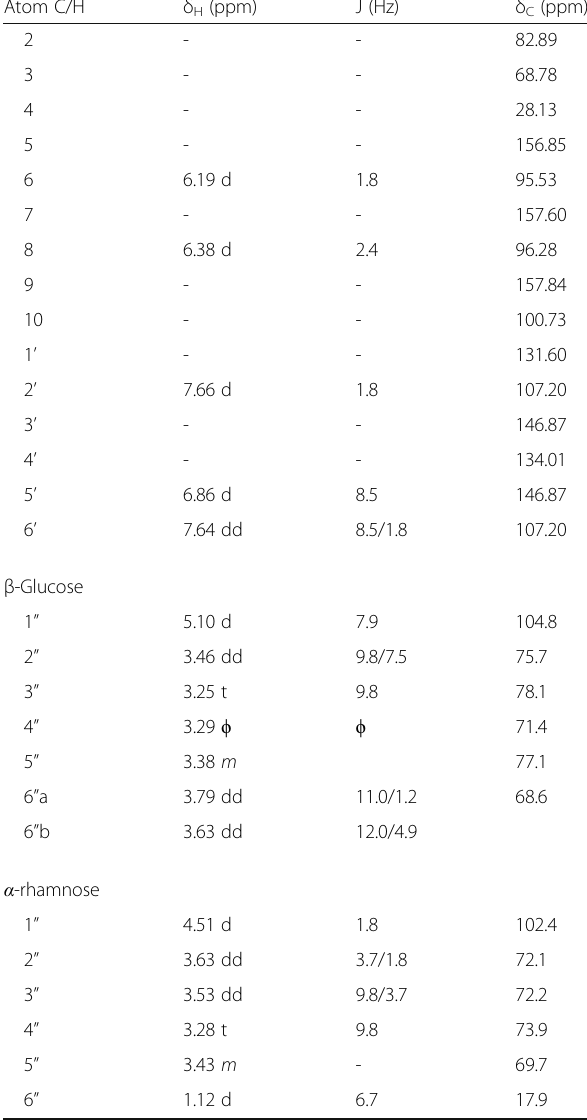
Table 3 Spectral determination of rutin in 1 H-NMR and 13 C-NMR